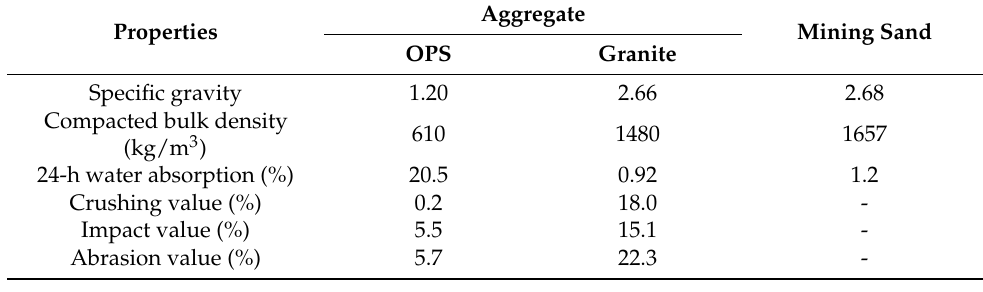
Table 3. Physical and mechanical properties of sand and aggregate.